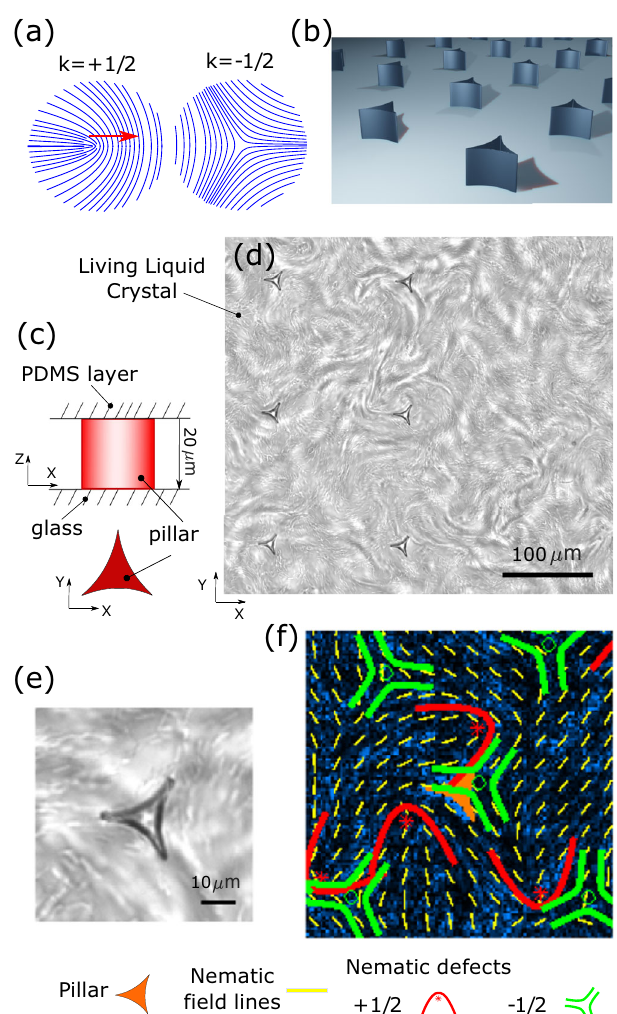
Fig. 1 Schematics of experiment and defect snapshots. a Nematic fi eld in the vicinity of + 1/2 and − 1/2 topological defects. b A schematic view of 3D model of a square lattice of pillars on a glass slide. c A side view of the microscopic pillar inside the experimental micro fl uidic chamber. d Bright fi eld microscope image of a living liquid crystal in the presence of pillars lattice. Scale bar is 100 μ m. e Snapshot illustrating position of bacteria around the pillar. Scale bar is 10 μ m. f Reconstructed nematic fi eld lines and topological defects in the vicinity of the pillar, the observation area 100 μ m × 100 μ m. Scale bar is 20 μ